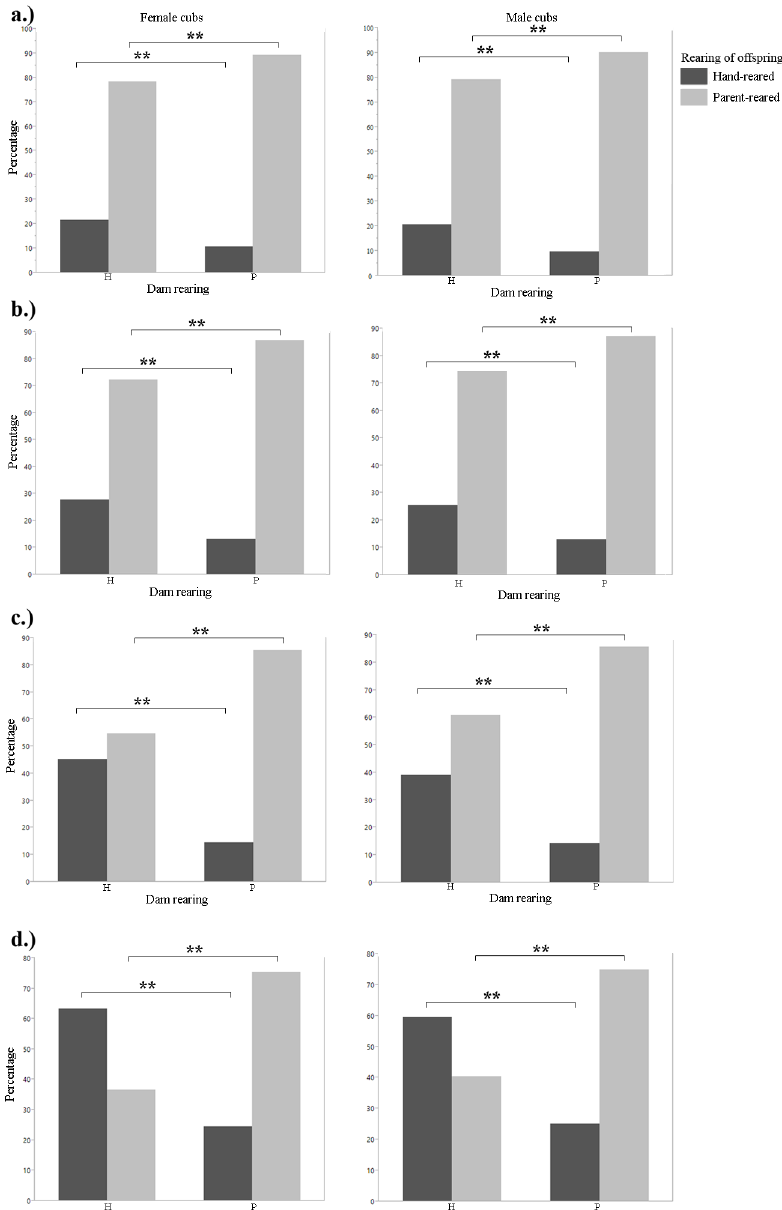
Fig 2. Percentage of female and male offspring that were reared by their dams or hand-reared (1901 – 2011). A). Siberian tiger B.) snow leopard C). cheetah D). clouded leopard. Fisher's Exact test: * p < 0.05; ** p <